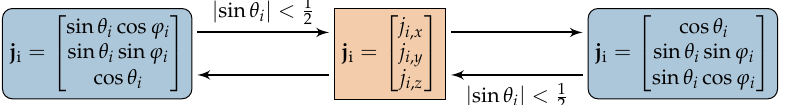
Figure 4. Two spherical parametrizations are used to represent the joint axes j i , i = 1,2, with two parameters each, θ i and ϕ i . To avoid the derivative becoming close to zero, we convert the respective axis to Cartesian coordinates and then to the other representation whenever